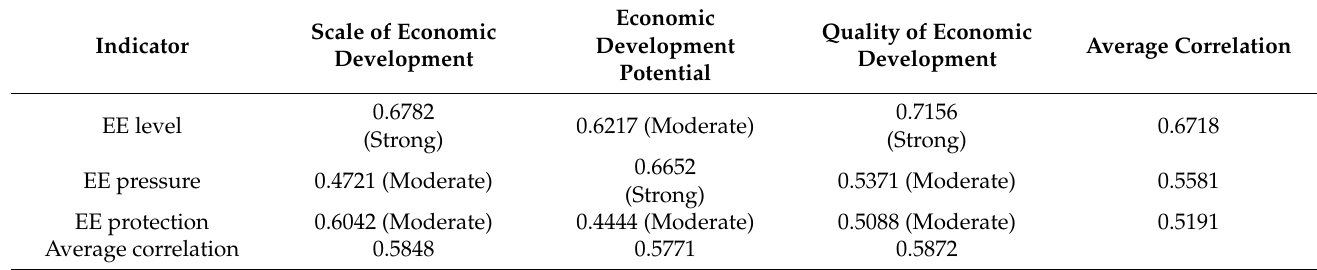
Table 5. Values and Ranks of ED and EE Subsystem Correlations in the YUA in